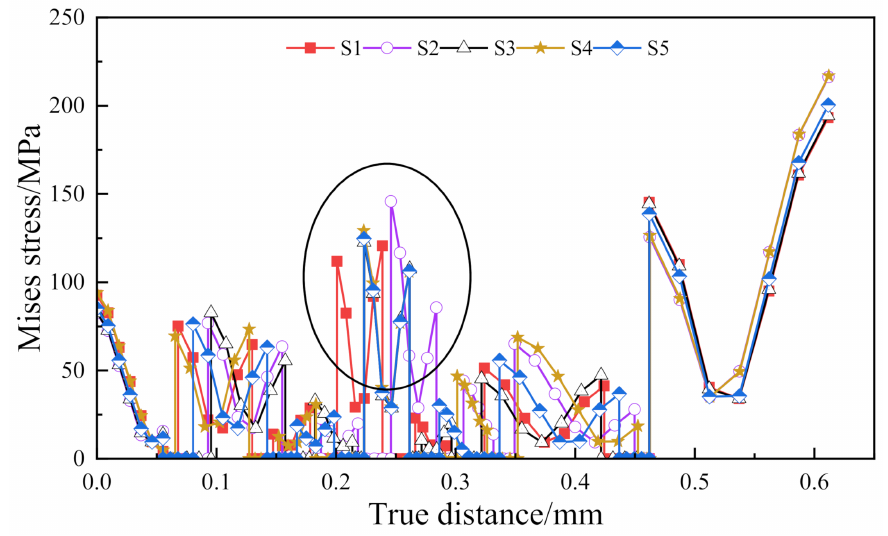
Figure 8. Mises stress distribution under the different OCA profiles. The Mises stress of the circled area is the stress of the OLED light-emitting layer.